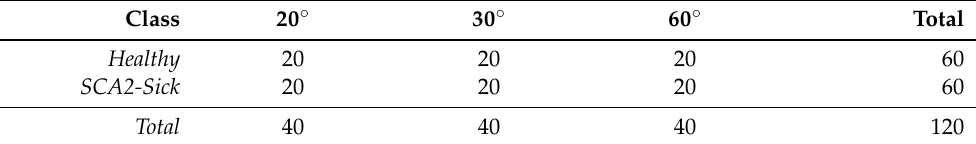
Table 1. Record distribution per subject status and angle.